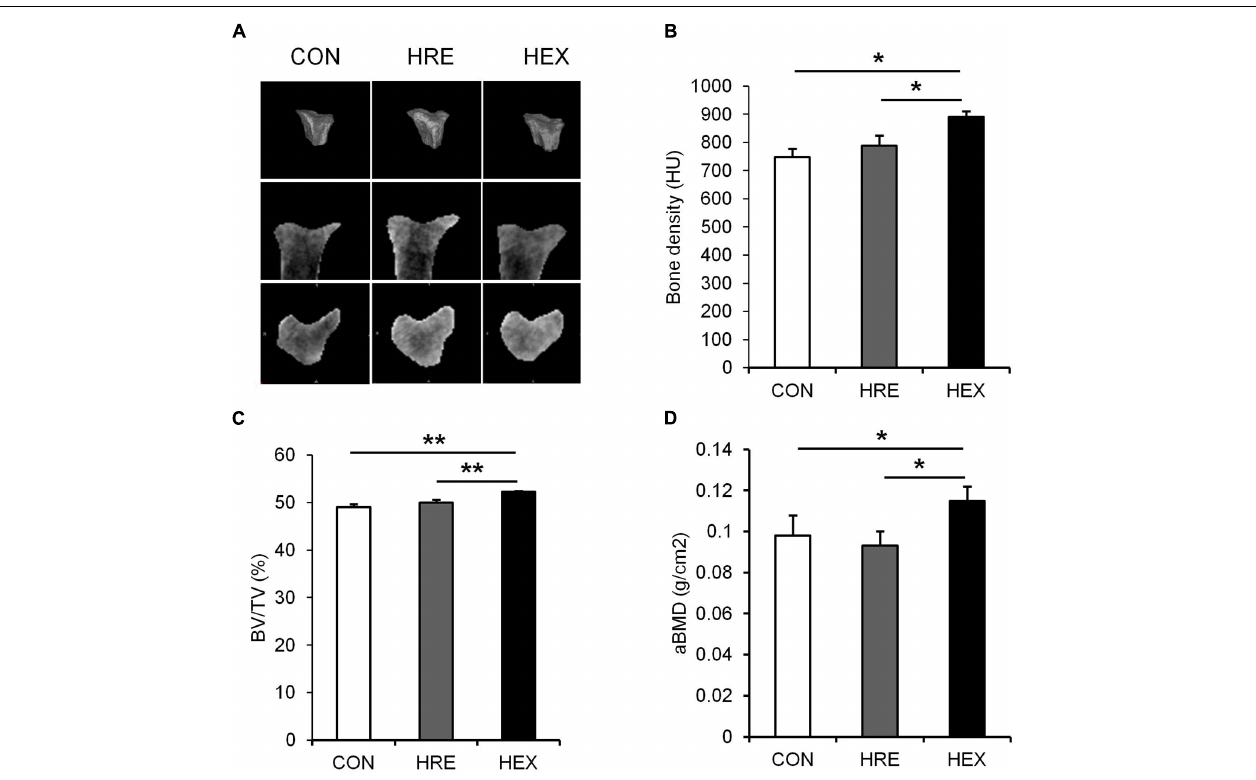
FIGURE 3 | The effects of re-ambulation and exercise on bone morphology following hindlimb suspension. (A) Representative micro-CT images of animals’ tibiae. (B) Bone density, (C) BV/TV, and (D) aBMD were measured after 4-week intervention. ∗ p < 0.05, ∗∗ p < 0.01. All the results were presented as mean ±